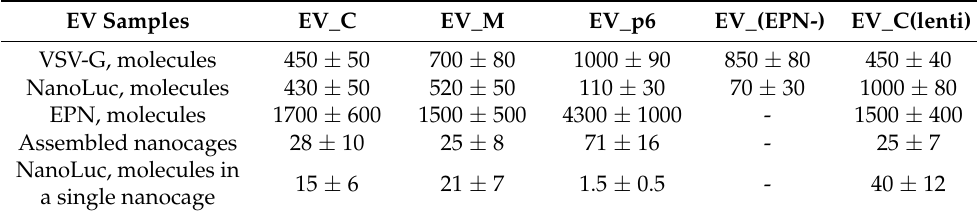
Figure 5. TEM analysis of the EVs. ( A , B )—TEM images of EVs obtained with co-transfection and lentiviral constructs, respectively. ( C ) Size distributions of the EVs according to TEM images. Table 2. The estimated number of recombinant protein molecules per single vesicle. The numbers of VSV-G proteins are derived from the quantitative Western blotting results (Figure S4), the numbers of NanoLuc proteins are derived from the luciferase assay measurement (Figure S5) and the numbers of EPN proteins are derived from the EPN/NanoLuc molar ratio estimated by MS/MS analysis (Table S2). Data represent the mean of three biological replicates ±